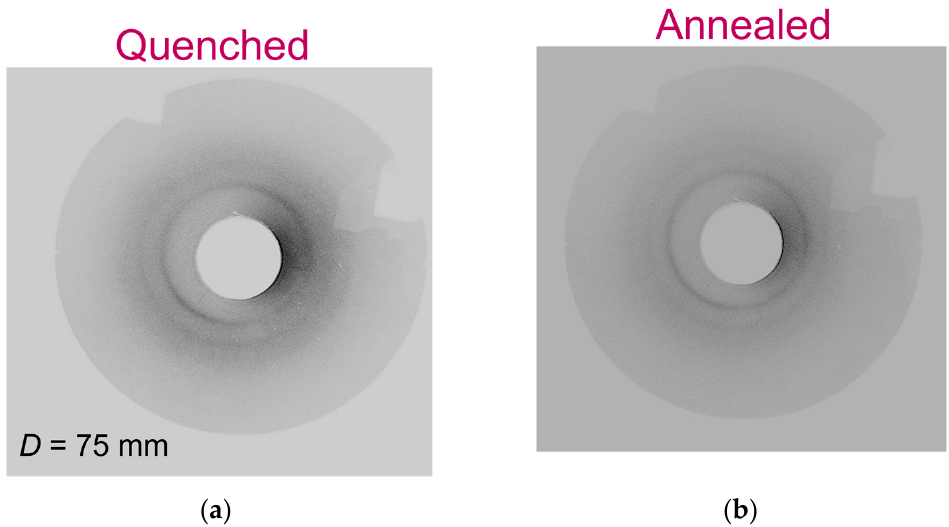
Figure 4. Debye-Scherrer patterns performed on PEF biaxially stretched in simultaneous and balanced conditions, followed by a quenching ( a ) or annealing ( b ) step.